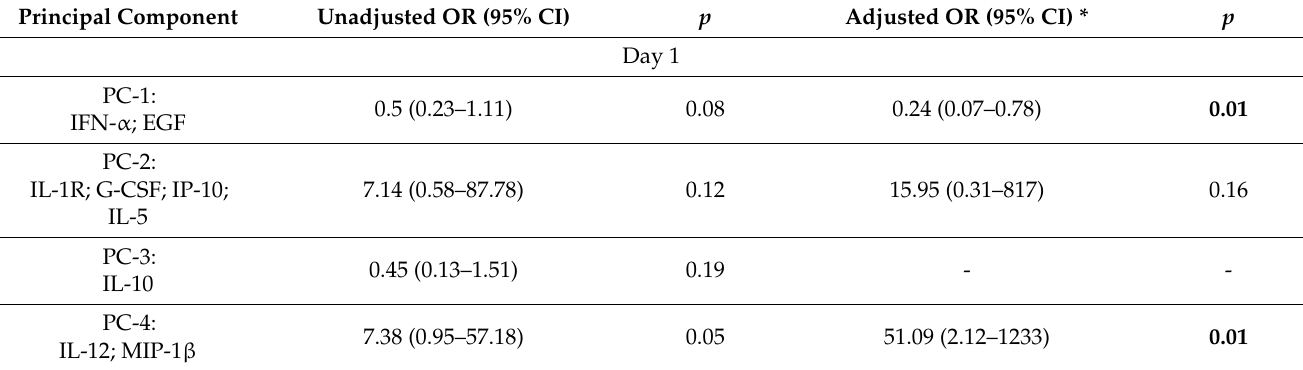
Risk of acute kidney injury associated with principal components in critically ill COVID-19